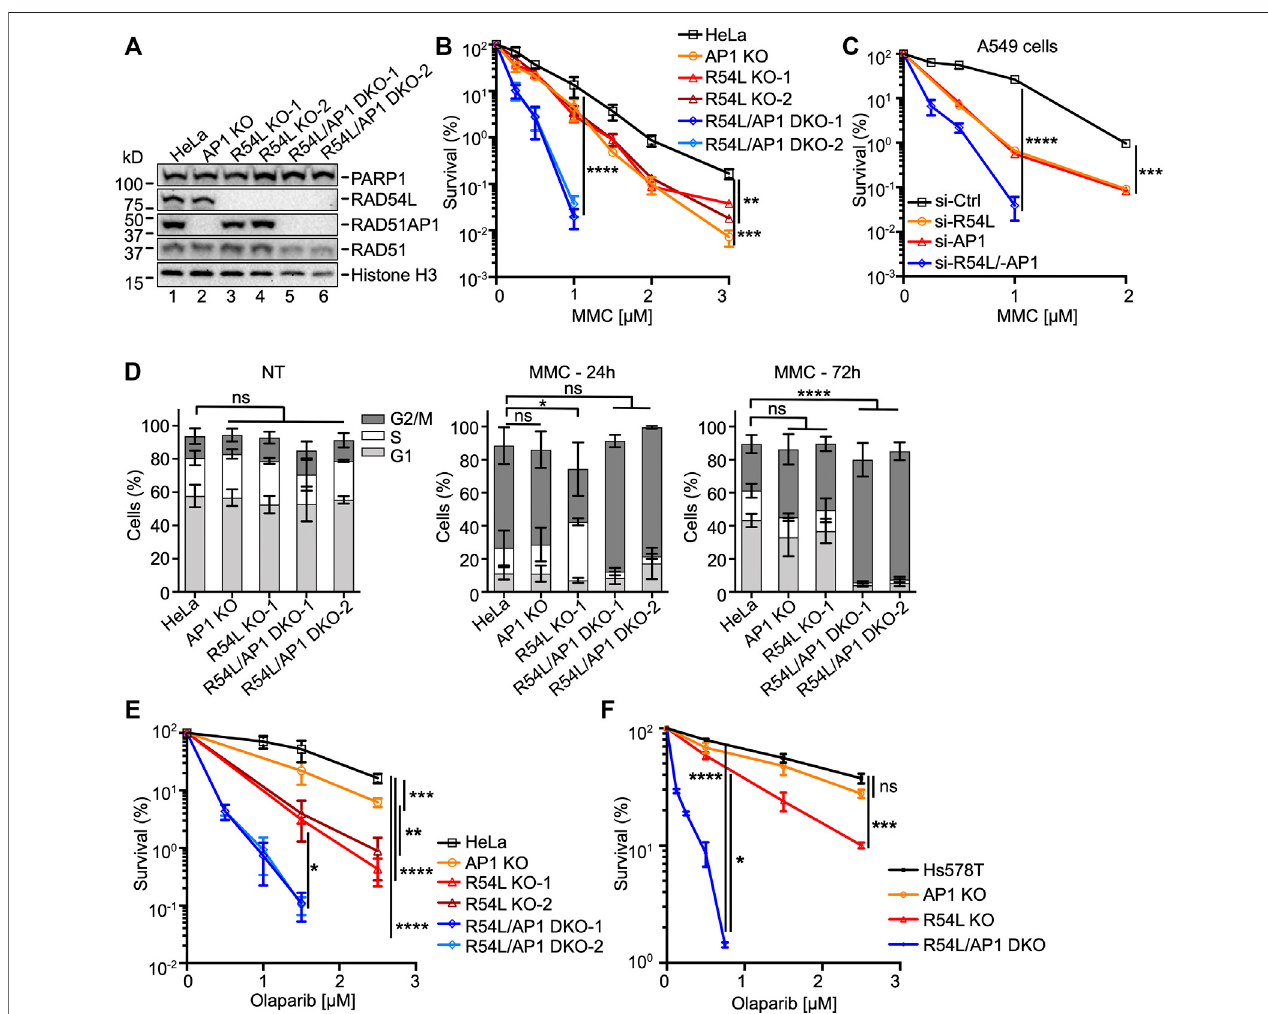
FIGURE 1 | De fi ciency of both RAD51AP1 and RAD54L exacerbates MMC cytotoxicity and cell cycle progression, and sensitivity to olaparib. (A) Western blots of nuclearextractsofHeLacellsandderivatives. RAD51AP1 KOcells(here:AP1KO),twoindependentlyisolated RAD54L KOcelllines(here:R54LKO-1,R54LKO-2),and two independently isolated RAD54L / RAD51AP1 DKO cell lines (here: R54L/AP1 DKO-1; R54L/AP1 DKO-2). Loading controls: PARP1, histone H3. (B) Results from clonogenic cell survival assays after MMC. Data points are the means from two to fi ve independent experiments ±SD. **, p < 0.01; ***, p < 0.001; ****, p < 0.0001; two-way ANOVA followed by Tukey ’ s multiple comparisons test. (C) Results from clonogenic cell survival assays of MMC-treated A549 cells with RAD51AP1 and/or RAD54L knockdown. Data points are the means from three technical replicates for A549 cells transfected with RAD54L siRNA (here: si-R54L) or RAD51AP1 siRNA (si- AP1), andfromtwoindependentexperiments±SDforA549cellstransfectedwithnegativecontrolsiRNA(si-Ctrl)orRAD54LandRAD51AP1siRNA(si-R54L/-AP1).***, p < 0.001;****, p < 0.0001;two-wayANOVAfollowedbyTukey ’ smultiplecomparisonstest. (D) AveragepercentageofcellsinG1,SandG2/Mcellcyclephaseswithout (here:NT(notreatment)),and24and72 hafterreleasefromMMC.Barsarethemeansfromatleastthreeindependentexperiments±SD.*, p < 0.05;****, p < 0.0001;ns, non-signi fi cant;one-wayANOVAfollowedbyDunnett ’ smultiplecomparisonstest. (E) ResultsfromolaparibclonogeniccellsurvivalassaysofHeLa,AP1KO,R54LKO- 1, R54L KO-2, and R54L/AP1 DKO-1 and DKO-2 cells. Data points are the means from three independent experiments ±SD. (F) Results from olaparib clonogenic cell survival assays of Hs578T, AP1 KO, R54L, and R54L/AP1 DKO cells. Data points are the means from three independent experiments ±SD. *, p < 0.05; **, p < 0.01; ***, p < 0.001; ****, p < 0.0001; ns, non-signi fi cant; two-way ANOVA followed by Tukey ’ s multiple comparisons test.